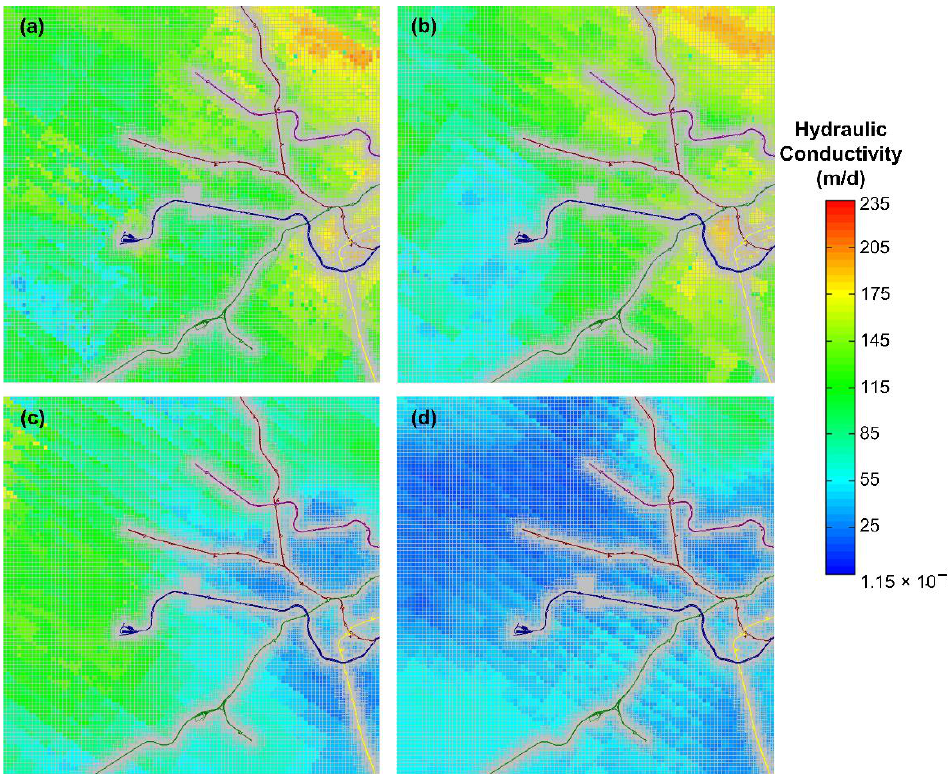
Figure 6. Hydraulic conductivity values for layers ( a ) 1 ( b ) 4 ( c ) 11 ( d ) 14. Please note that subway line tracks are plotted inside all layers to provide refence points, since the grid is not rotated in these images.